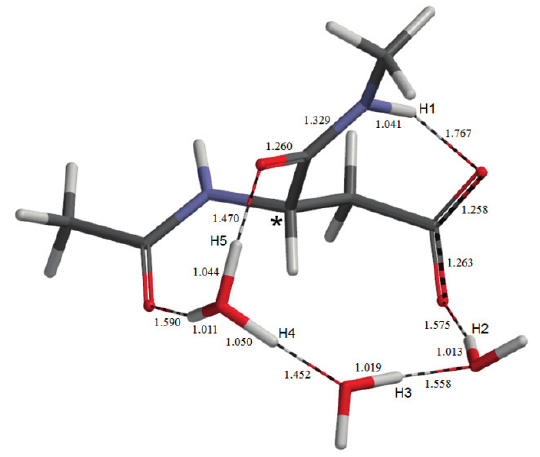
Figure 4. The geometry of the first intermediate DP . Selected bond distances are shown in